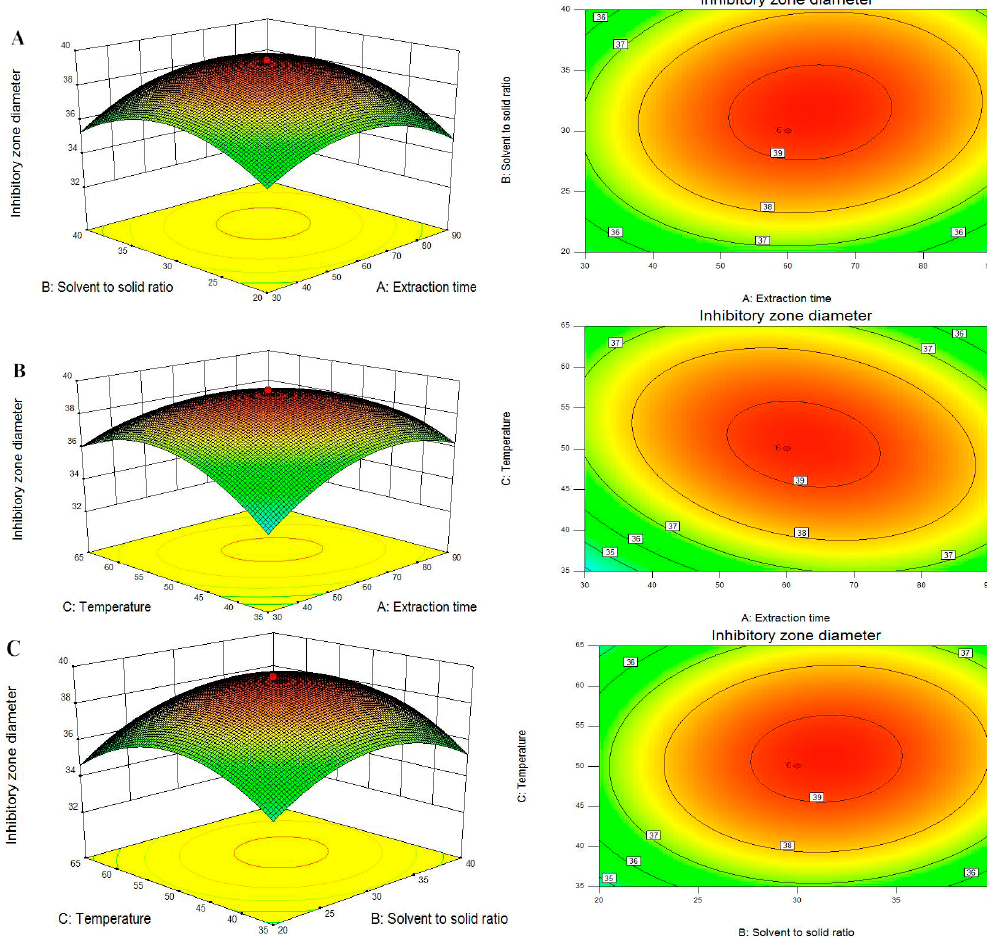
Figure 4. Response surface plot and contour plot showing DIZs against P. digitatum of extraction time and solvent to solid ratio ( A ); extraction time and temperature ( B ) and solvent to solid ratio and temperature ( C ).